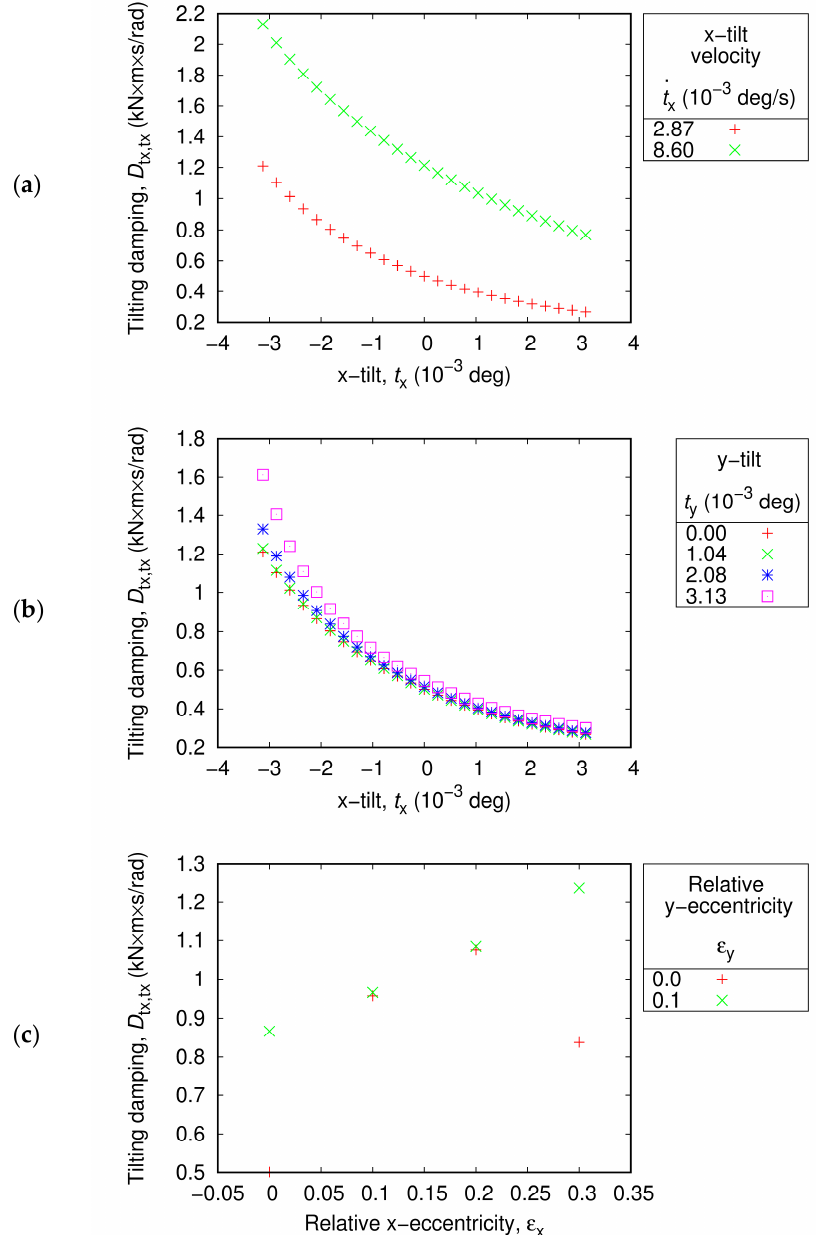
Figure 8. Parameter sensitivity of the direct damping coefficient D tx , tx : ( a ) Effects of the tilting angle and tilting velocity in the x-direction; ( b ) Effects of the x and y tilting angles; ( c ) Effects of the relative eccentricities. All unreferenced parameters have zero values.